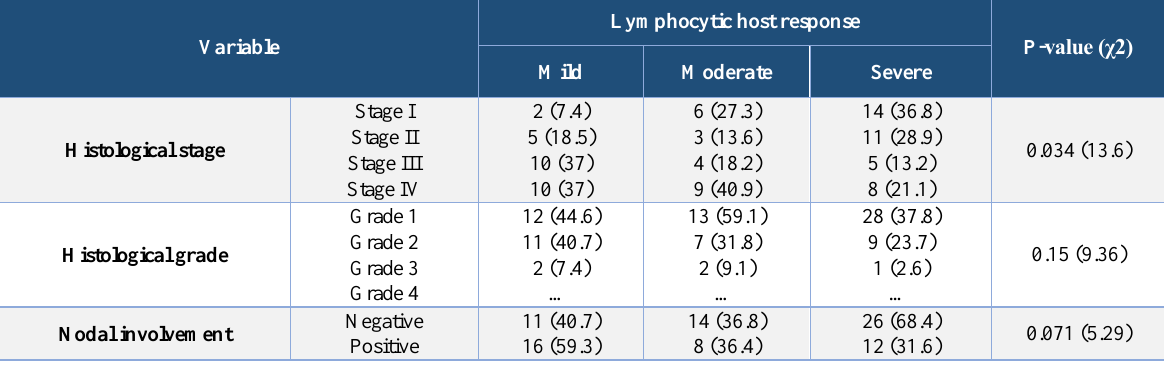
Table 3. Relationship between lymphocyte host responses with studied clinicopathological parameters